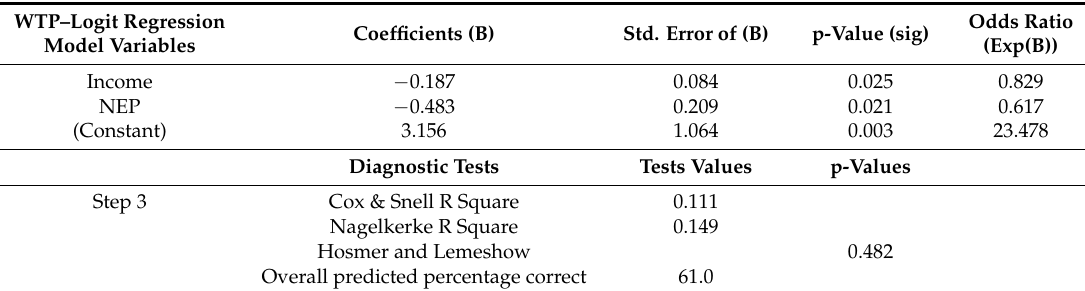
Table 7. Binary logistic regression model examining willingness to pay for green energy expansion (WTP), coefficients and diagnostic